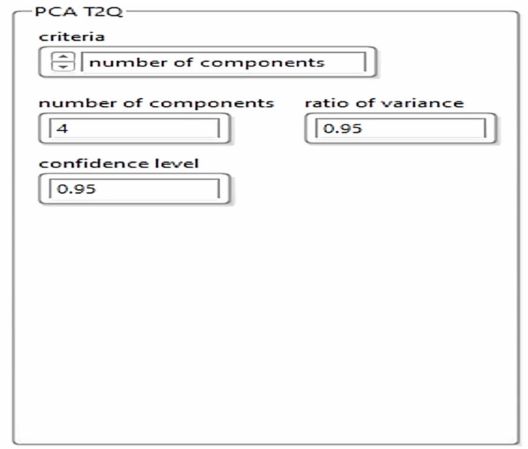
Figure 13. Software implementation of the PCA T 2 Q training